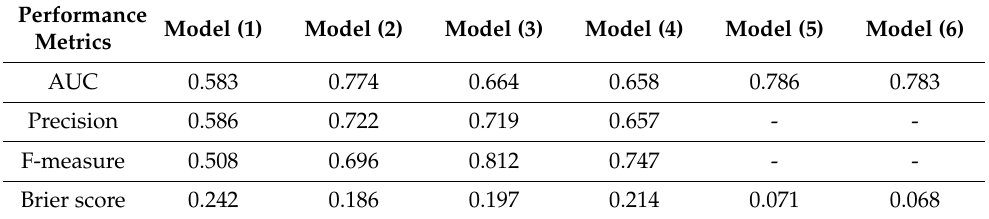
Table 15. The performance indicators of the used models .